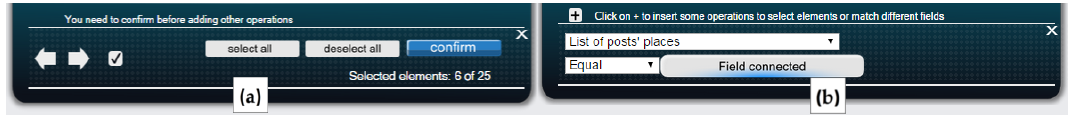
Figure 8. Content filtering for a photo widget. In the ( a ) part, the user manually selects the photos to be retrieved. In the ( b ) part, the user defines a filter that automatically selects the posts created in location specified in another widget. Clicking the “Field connected” button, the environment automatically highlights the data